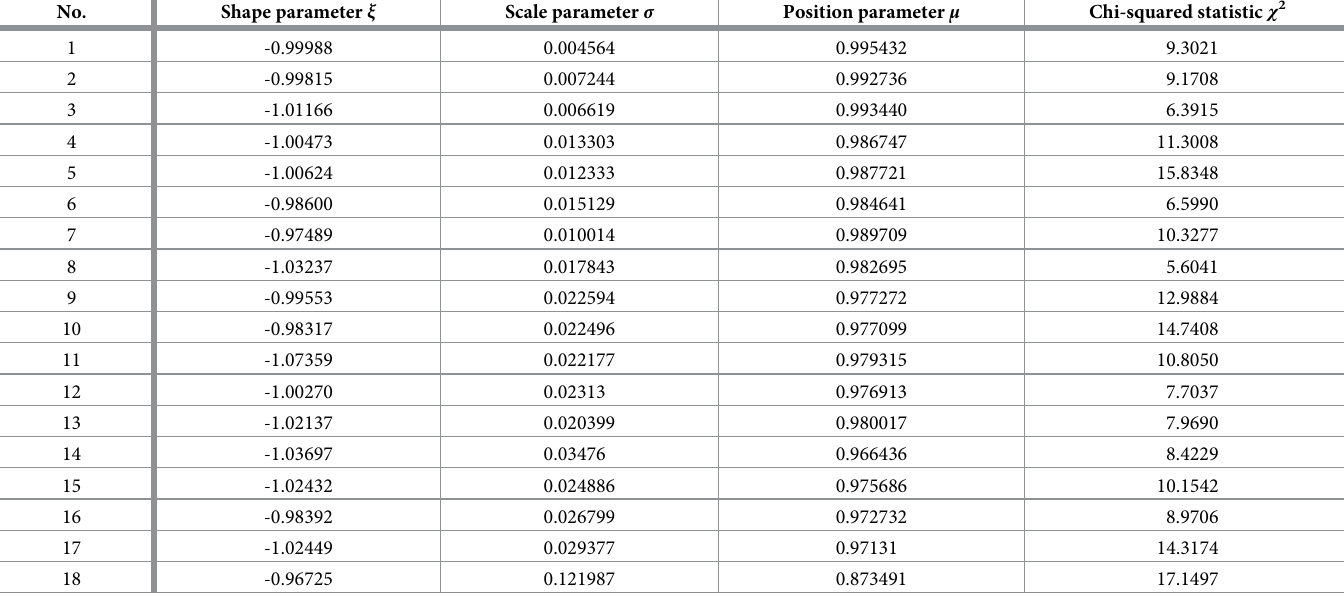
Table 3. Distribution fitting results for experiments in Table 2.